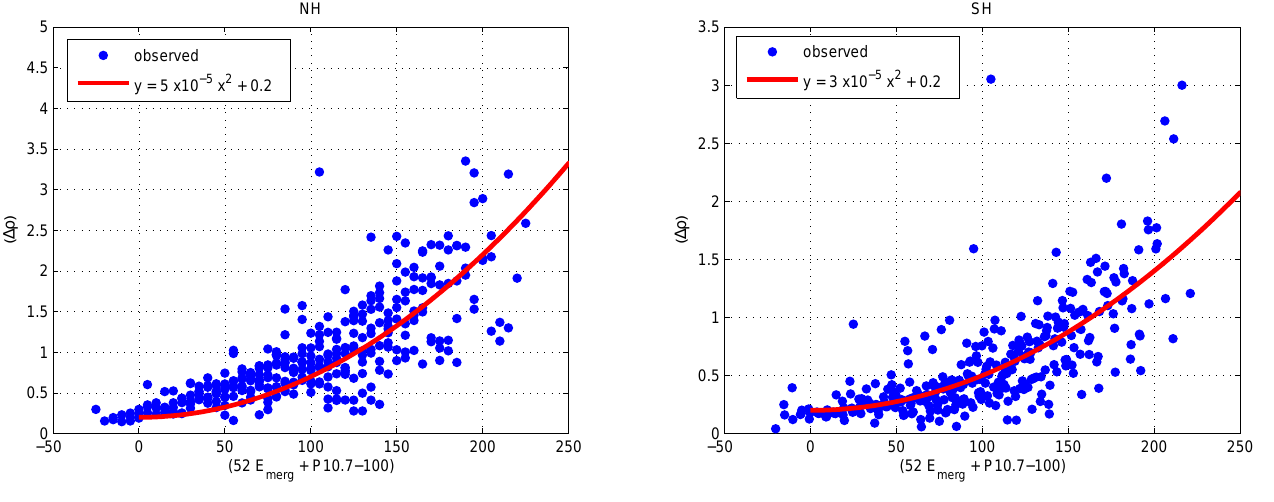
14 Fig. 9. Dependence of the density anomaly on the optimal linear combination of the controlling parameters. There seems to be a quadratic relation between the anomaly strength and the parameters. The orange curve represents the parabolic best fit to the observations ( a NH = 5 × 10 − 5 and a SH = 3 × 10 − 5 ).